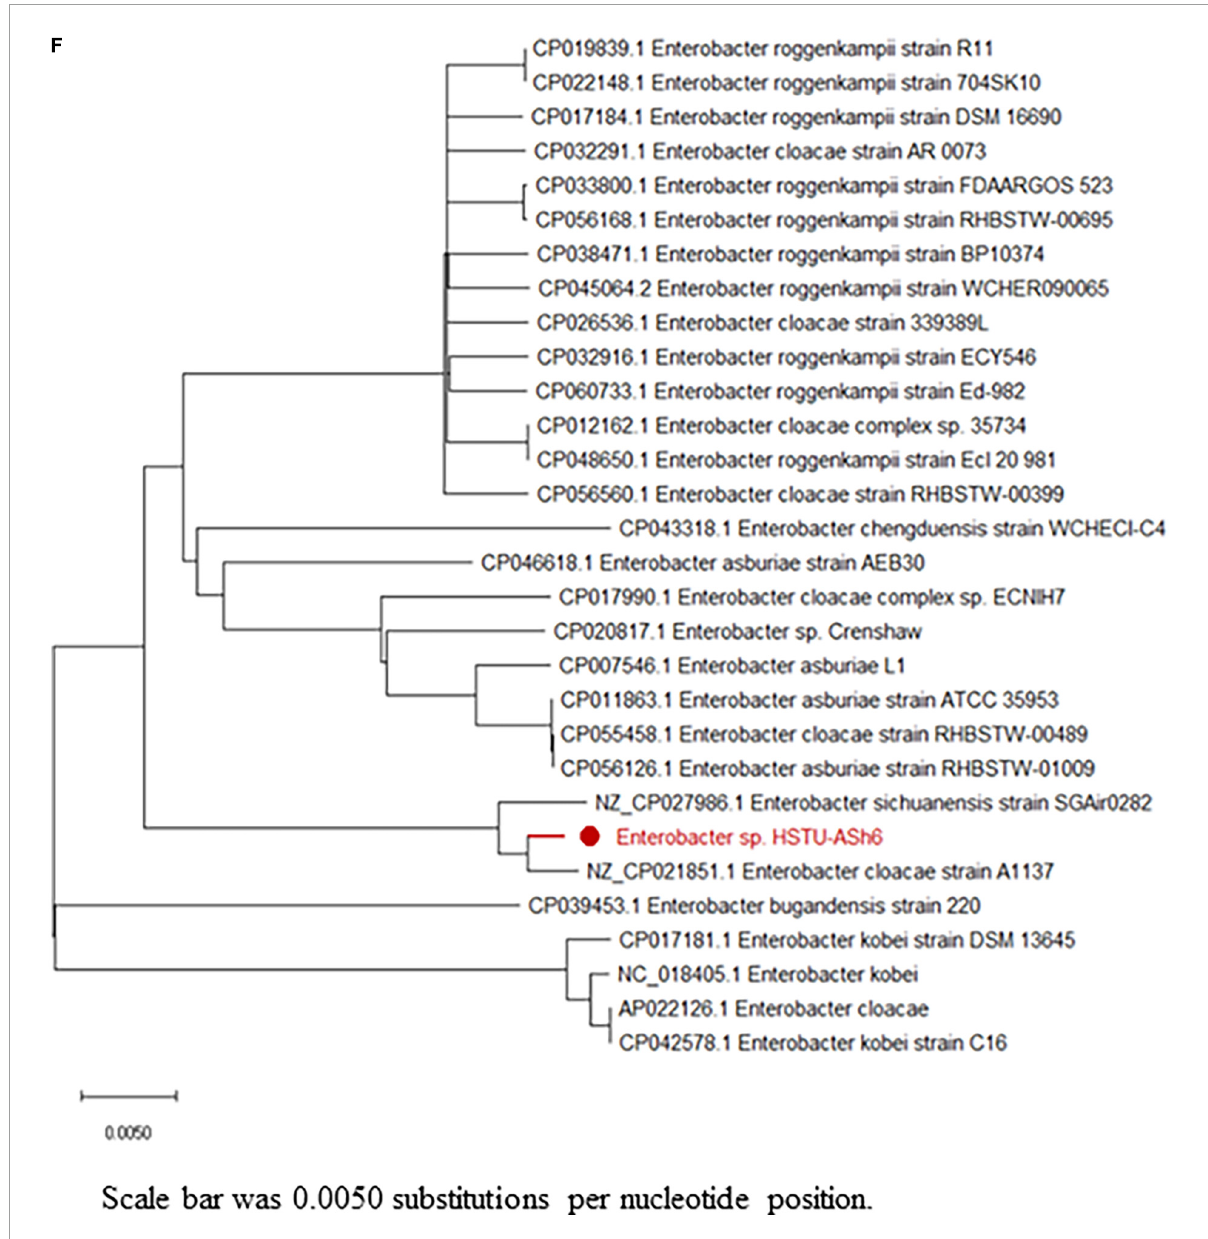
FIGURE3 Phylogenetic tree constructed using the housekeeping genes of HSTU-ASh6. (A) 16S rRNA, (B) gyrase B, (C) RecA, (D) rpoB, (E) tonB, and (F) whole genome phylogenetic tree of Enterobacter sp. HSTU-ASh6.